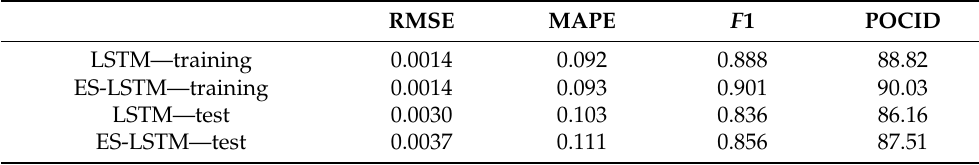
Table 3. EUR–USD: accuracy comparison.